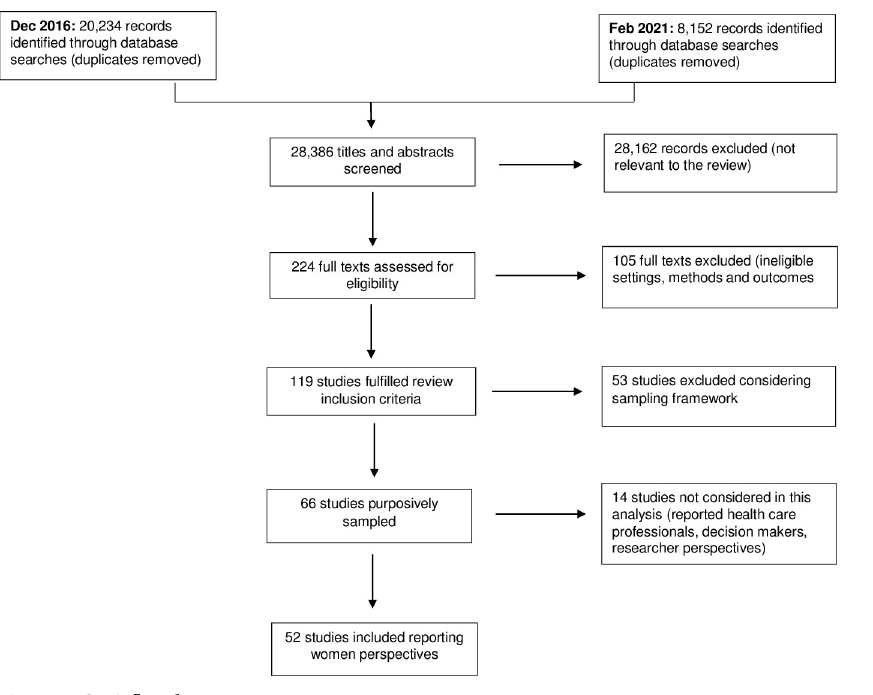
Fig 1. PRISMA flow